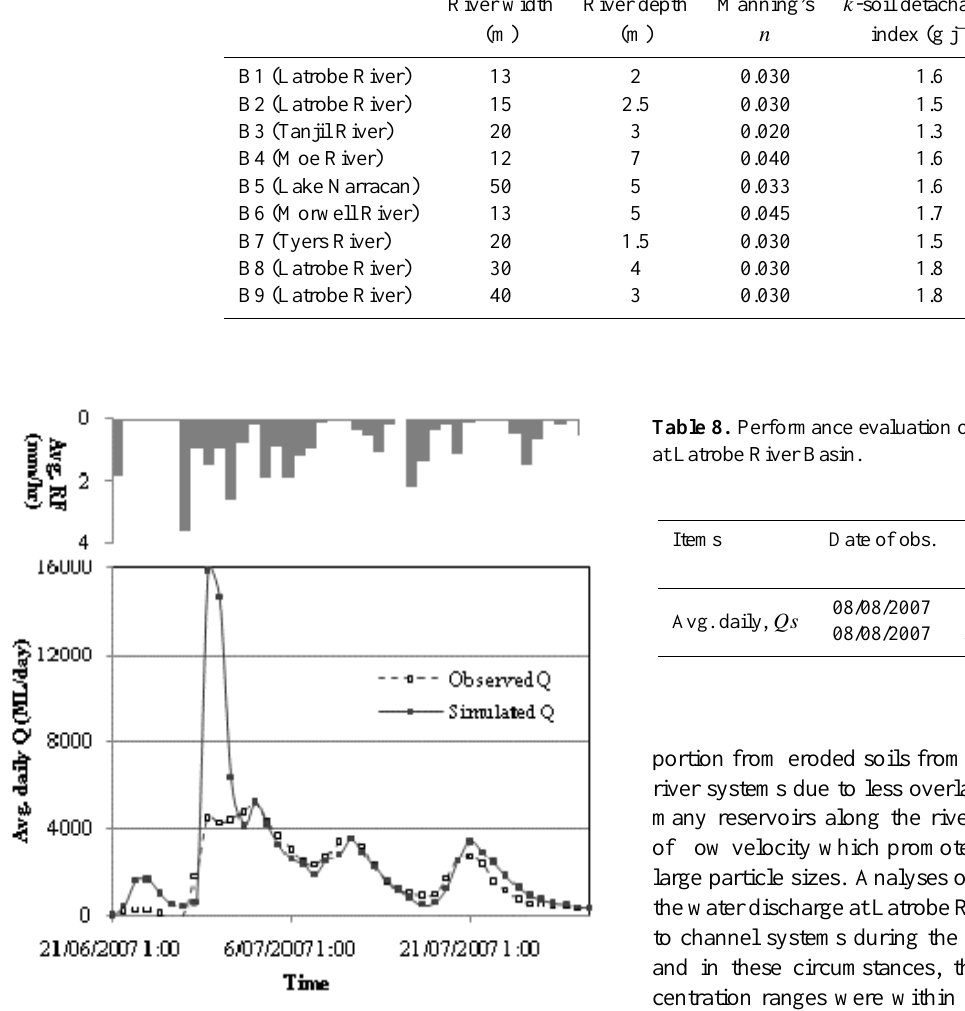
Fig. 15. Qs with different soil cohesion values at Tateyama station.